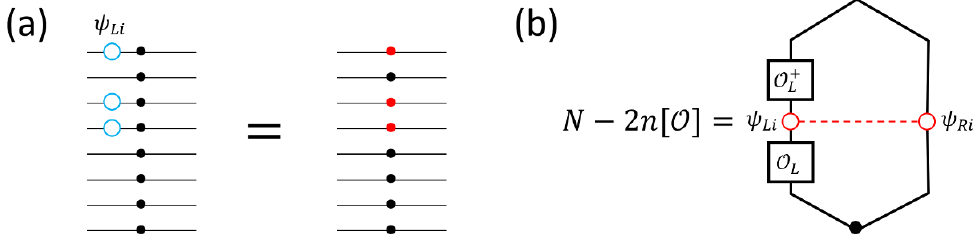
Figure 2 . (a) The mapping of a Majorana string (cid:0) I in eq. (2.5) to a state in the doubled system. Each fermion operator Li creates a fermion (red dot) while the fermions that are absent in (cid:0) I stays in the vacuum state with fermion number 0 (black dot). (b) Illustration of the relation between average size of operator O and